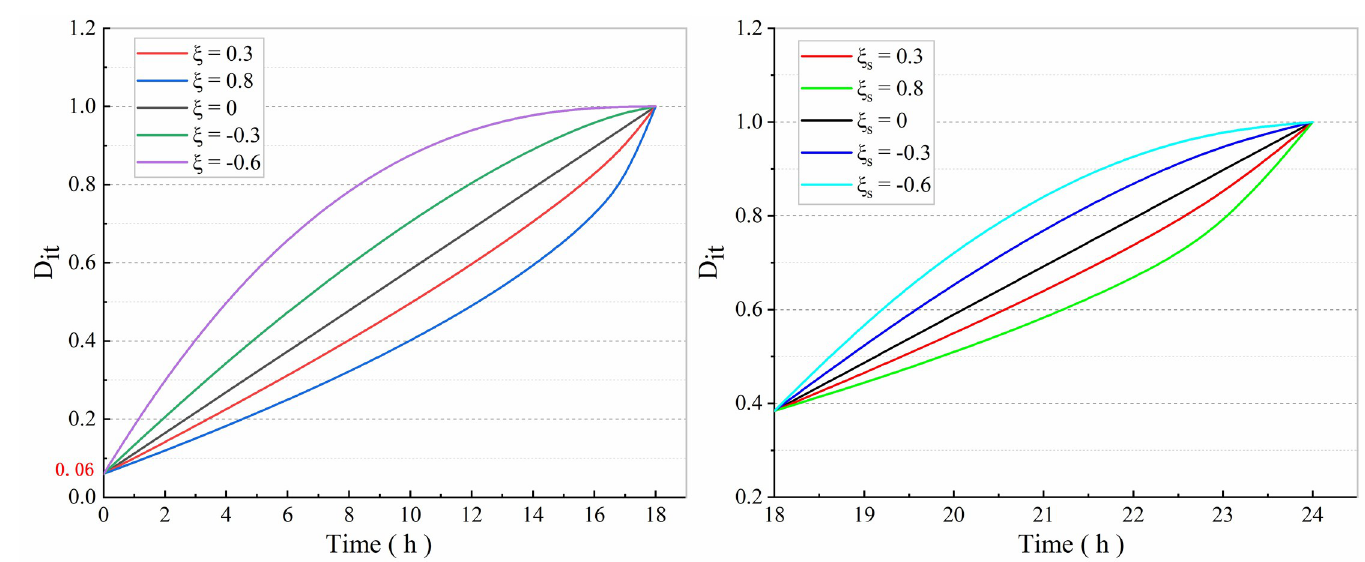
Fig 4. Time-dependent damage evolution curves under different z and z